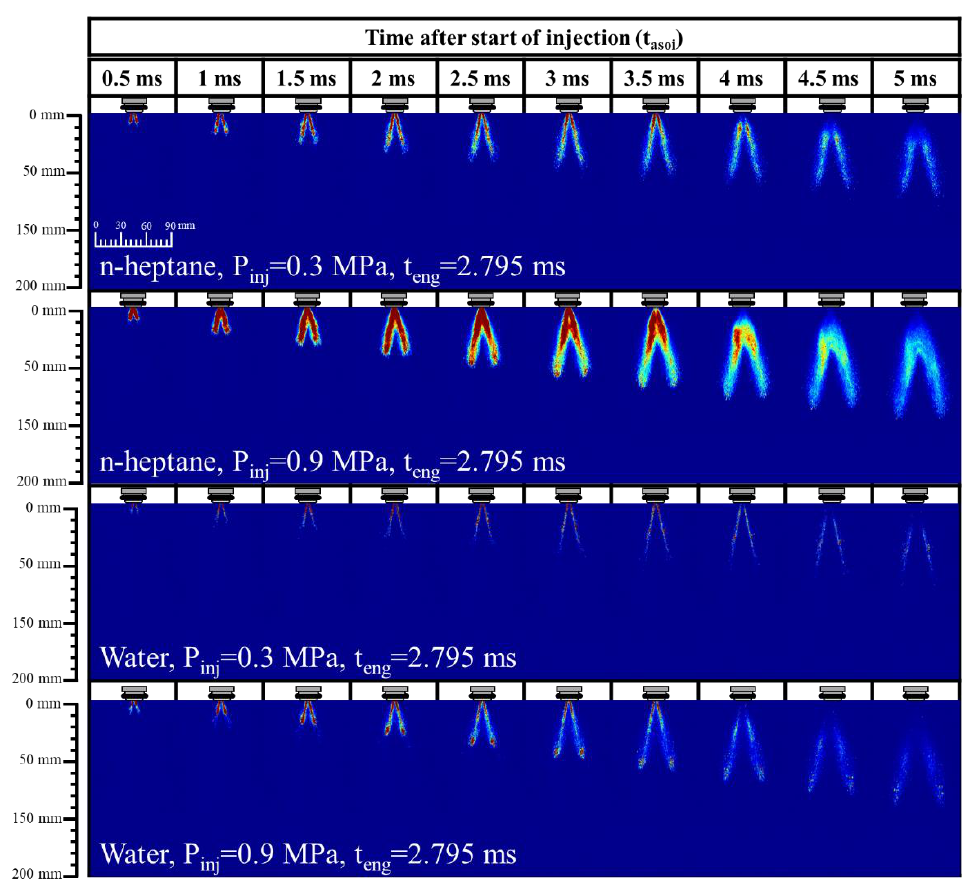
Figure 5. Spray developing process of water and n-heptane according to the time after start of injection (P inj = 0.3 MPa and 0.9 MPa, P amb = 0.1 MPa, t eng = 2.795 ms).